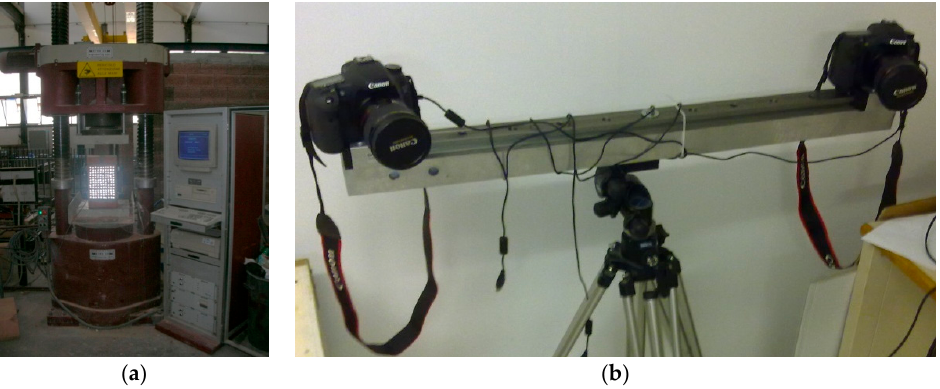
Figure 7. ( a ) Sample prepared with the markers and set up on the press for the compression test; ( b ) equipment for image acquisition.